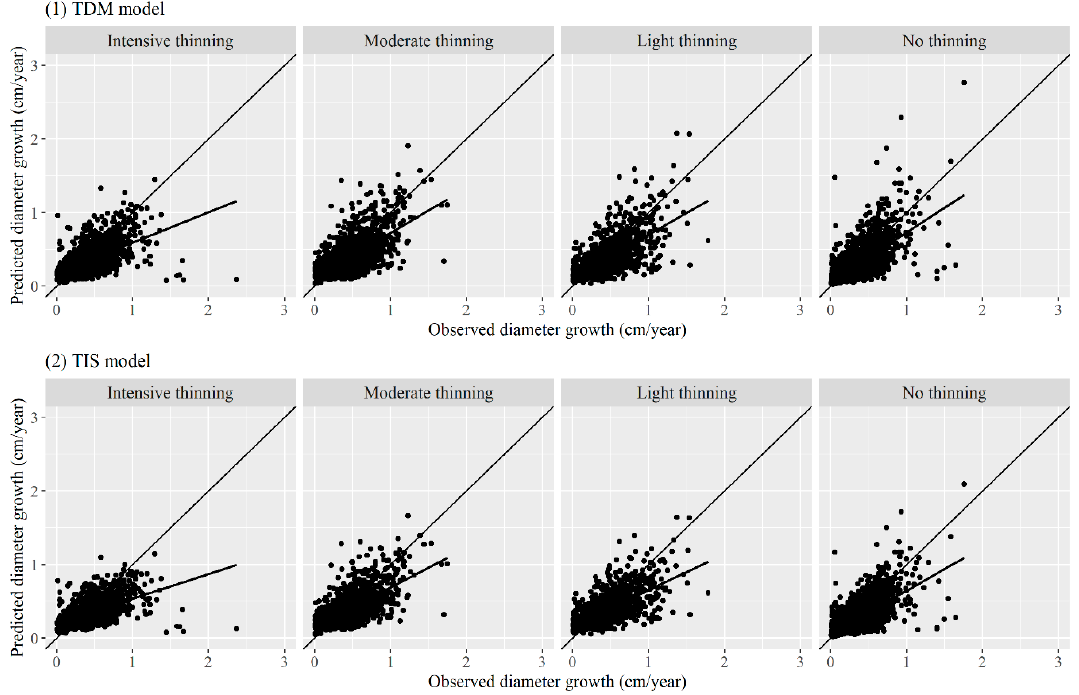
Figure 2. The relationship between predicted and observed diameter growth under different thinning intensities for the ( 1 ) TDM model and ( 2 ) TIS model. Note: Predicted diameter growth was calculated by the best model of TDM model according to Table 4, and the best model of TIS model according to Table 6. Table 7. Evaluation of TDM and TIS models using Sr under different thinning intensities. RMSE (cm) rRMSE (%) Bias (cm) Variance (cm) TDM TIS TDM TIS TDM TIS TDM TIS